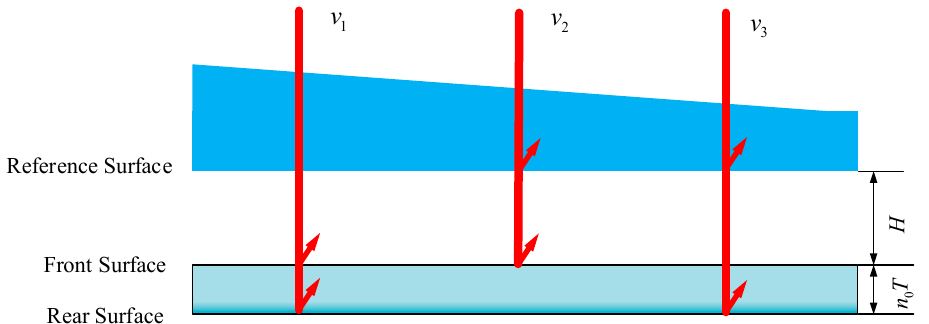
Figure 1. Diagram of the reflected rays forming the interferogram.